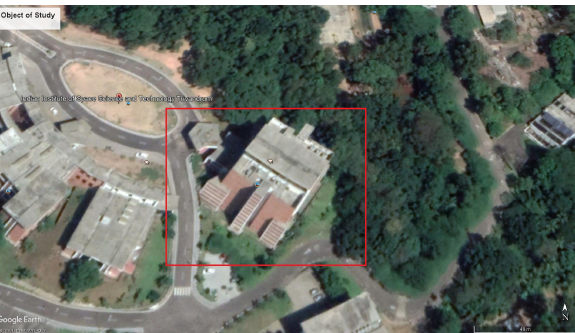
Figure 1. Google Earth imagery of the object of study (IIST Library).